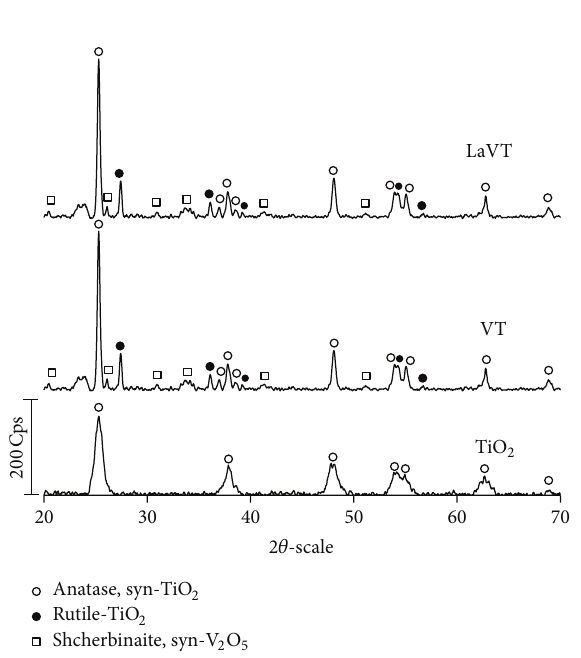
Figure 1: XRD patterns of TiO 2 , VT, and LaVT samples.